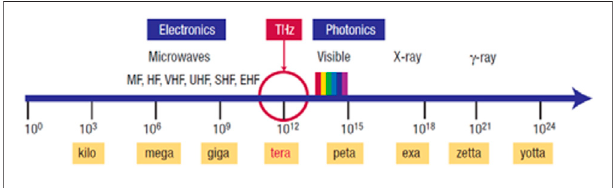
FIGURE 1 | The spectrum of THz wave [2].